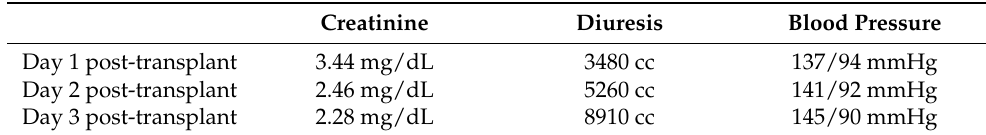
Table 3. Graft evolution markers during the first 3 days after transplantation. cc: cubic centimeters; mmHg: millimeters of